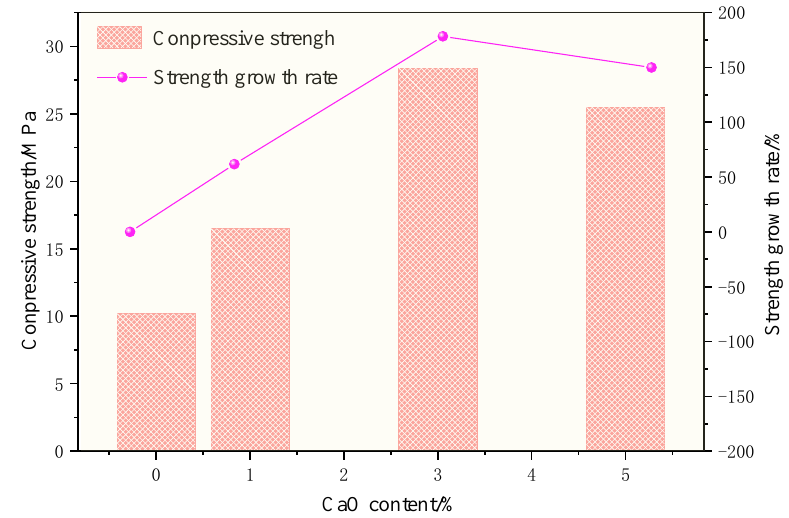
Figure 7. Effect of CaO content on compressive strength of CDWGP.